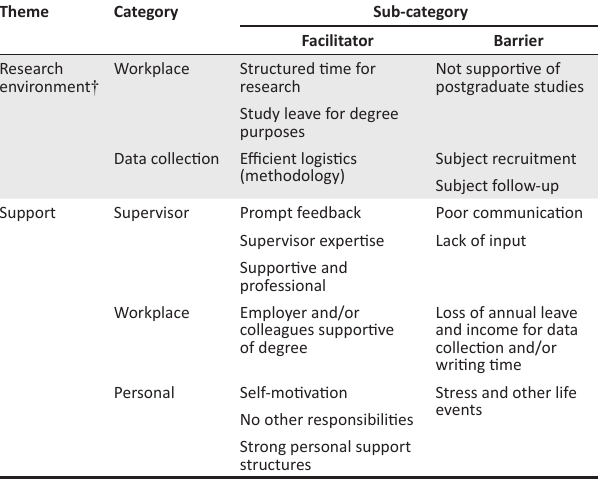
TABLE 2: Themes, categories and sub-categories identified in the